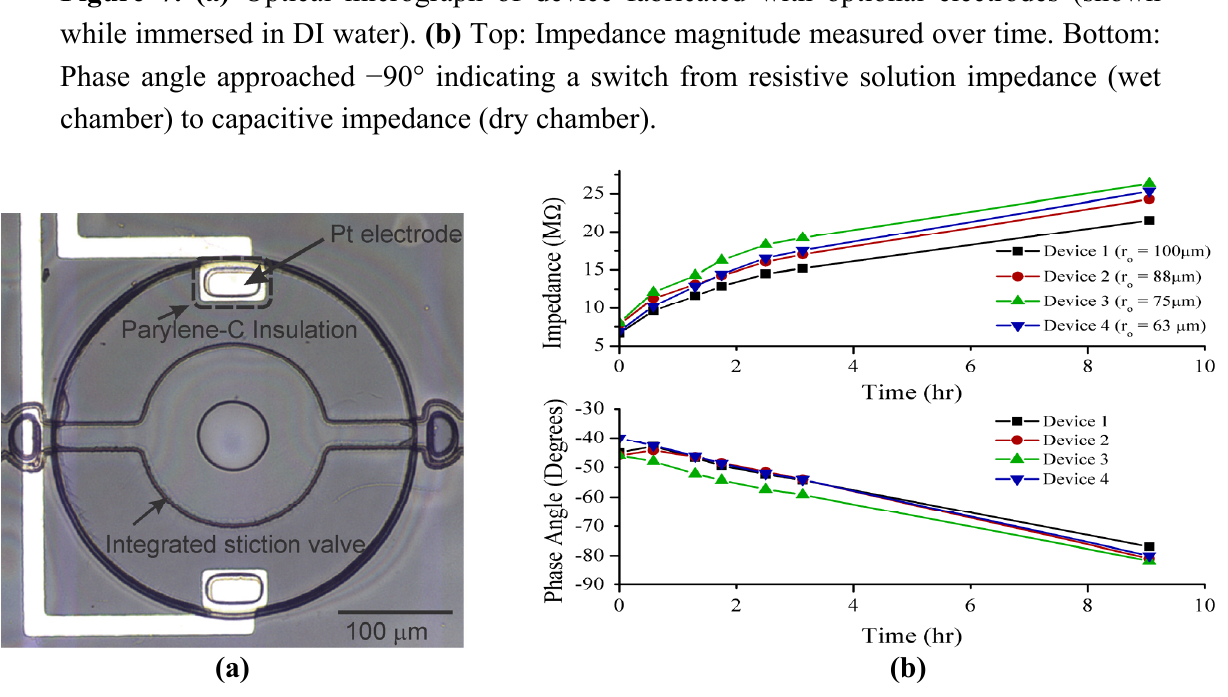
Figure 8. Liquid volume measured over time (mean ± SD, n = 4). The measured